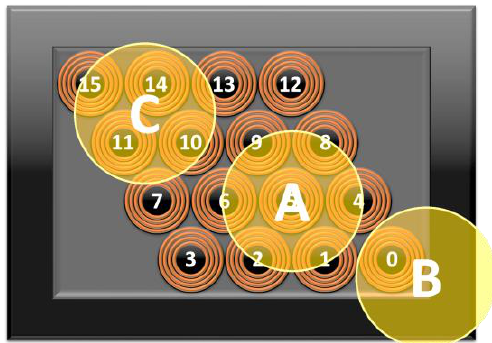
Figure 3. Different receiving coil positions on the top of the proposed coil system, position A is the ideal position, position B extremely misalignment and position C misalignment are the worst positions.